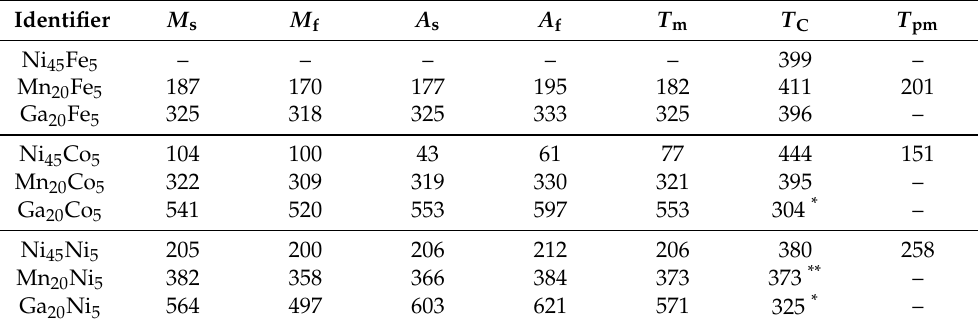
Ga 20 Fe 5 325 318